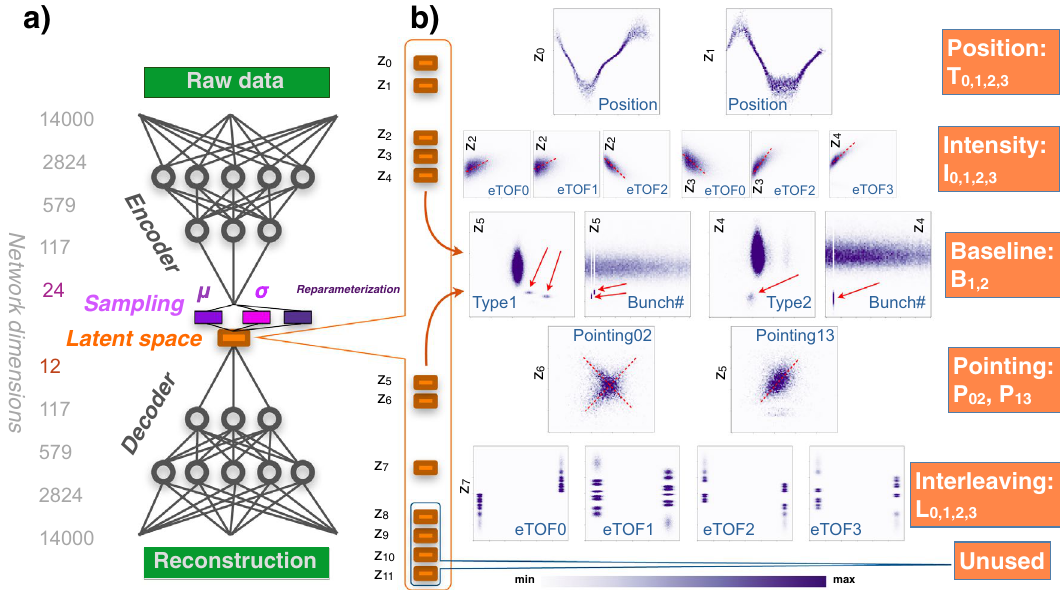
Figure 2. The structure of the β -VAE-network ( a ) and the unsupervised encoding of the underlying core principle ( b ), i.e. position, intensity, baseline, pointing and interleaving, is shown. The density plots represent the dependency of the latent space vs. the labels, which were derived by traditional data analysis using the high quality data (3% of the data set). The values in the corresponding axis ( z i and labels) are min–max-normalised for the processed test samples. All scales are